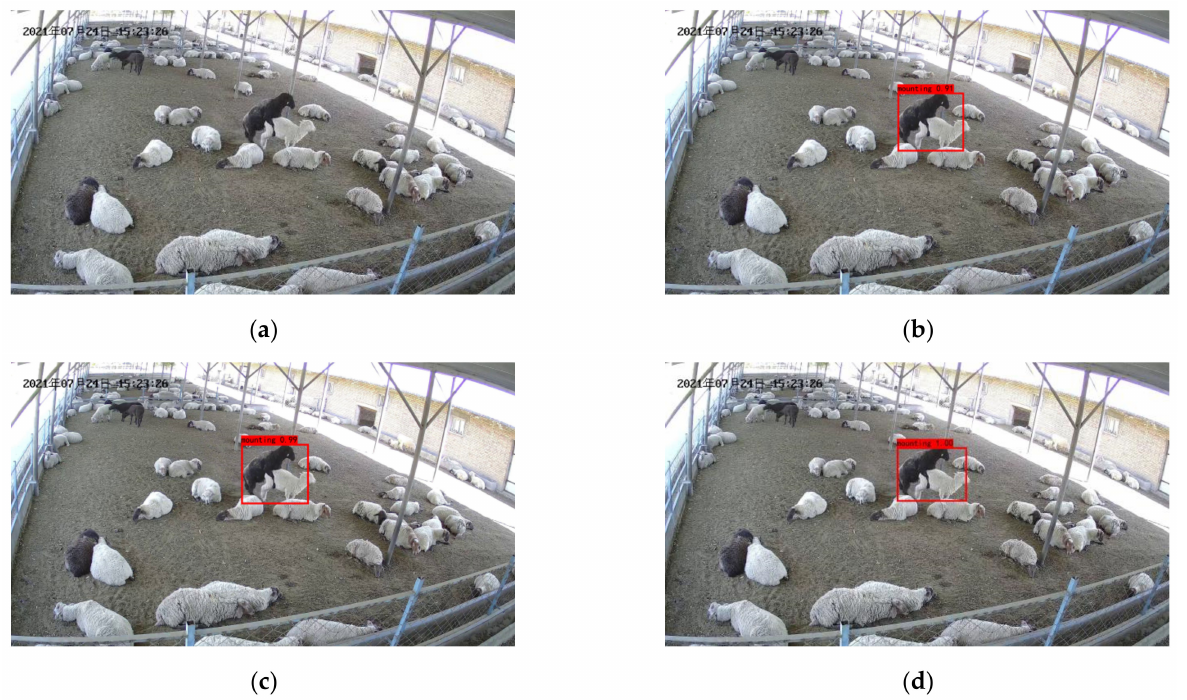
Figure 10. Analysis of near-range detection results: ( a ) Original image; ( b ) YOLO v3 + EfficientNet-B0 recognition effect; ( c ) YOLO v3 recognition effect; ( d ) ES_YOLO v3 recognition effect. The Chinese in the upper left corner of the image is the date of the video recording, in order of year, month and day.